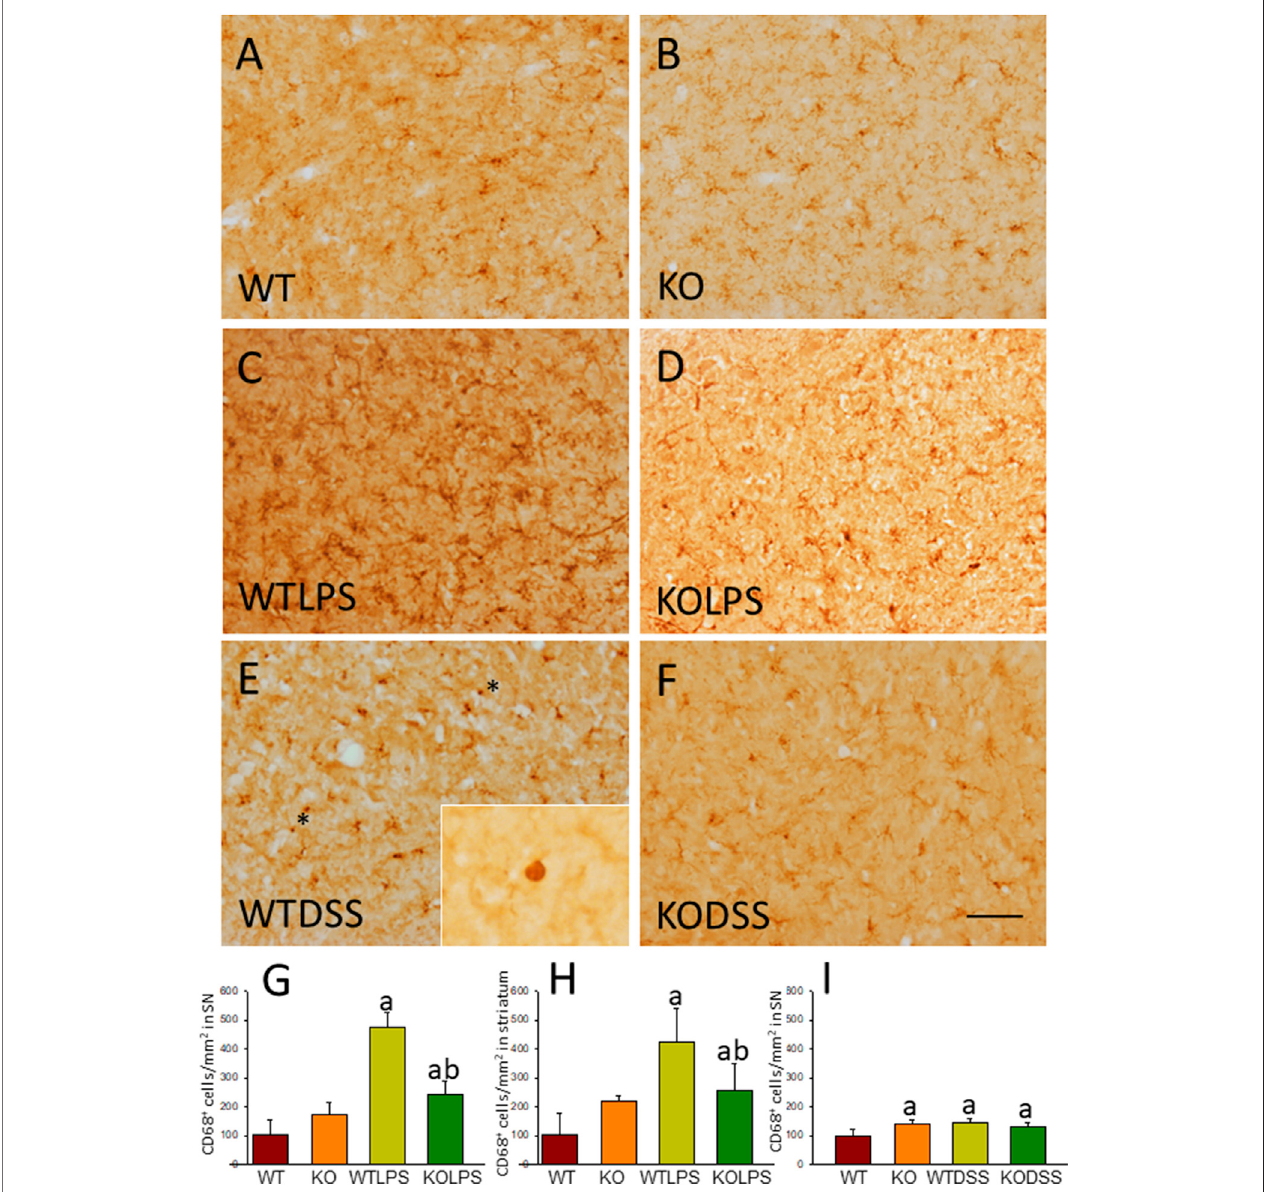
FIGURE 4 | CD68 expression in LPS and DSS treated mice. Representative immunostaining from sections of the different treatments assayed. SN of WT (A) animalsshowanormalpatternofCD68expression.Gal3KO (B) animalsshowaslightincreaseintheexpressionofCD68inSN.WTLPSanimals (C) showanincreasein the number ofCD68 positivecells while theabsenceofGal3 inGal3KOLPS (D) animals reducesthisinduction. Treatment withDSS inWT animals (E) alsoincreases the numberofCD68positivecells.NoticetheamoeboidmorphologytypicalofhighlyreactivemicrogliainWTanimalstreatedwithDSS.AbsenceofGal3inDSStreated animals (F) do not reduce the number of CD68 positive cells but clearly avoid the presence of highly activated microglia with amoeboid morphology. Scale bar: 125 μ m. (G) Quanti fi cation of the density of CD68 positive cells in SN of LPS treated mice. (H) Quanti fi cation of the density of CD68 positive cells in the striatum of LPS treated mice. (I) Quanti fi cationofthedensityofCD68positivecellsinSNofDSStreatedmice.Resultsaremean ± SDofatleastthreeanimalsperexperimentalgroup,expressed as the number of CD68 positive cells per mm 2 . Statistical signi fi cance: One-way ANOVA followed by the Fisher ’ s LSD post hoc test for multiple comparisons was used, with α (cid:2) 0.05: (a) , compared with the WT group; (b) , compared with the WTLPS group; p < 0.05. Abbreviations: WT, wild type mice; WTLPS, WT animals treated with LPS;KOLPS,Gal3knockoutmicetreatedwithLPS;WTDSS,wildtypemicetreatedwithDSS;KO,Gal3knockoutmice;KODSS,Gal3knockoutmicetreatedwithDSS.